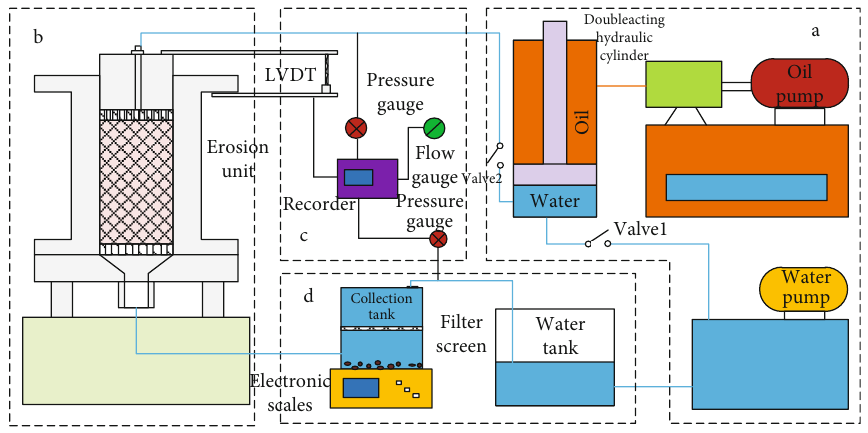
Figure 3: Test system. Note: (a) fl uid supply system, (b) erosion unit, (c) data acquisition system, and (d) particle collection